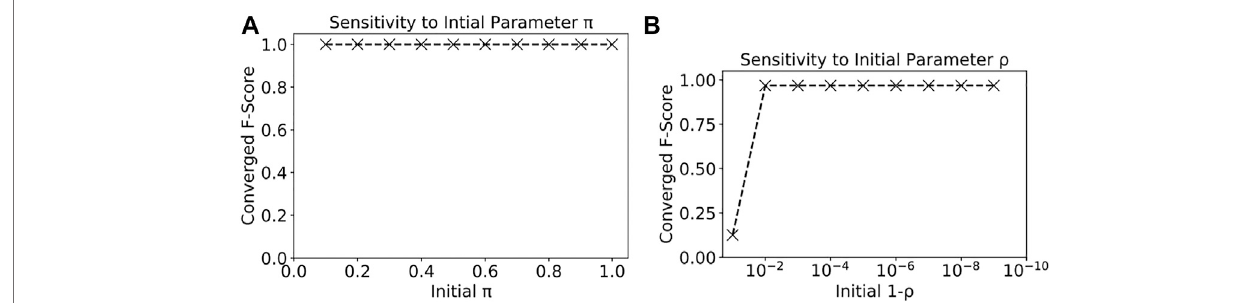
FIGURE 4 | Sensitivity of our model to initial parameters π and ρ .